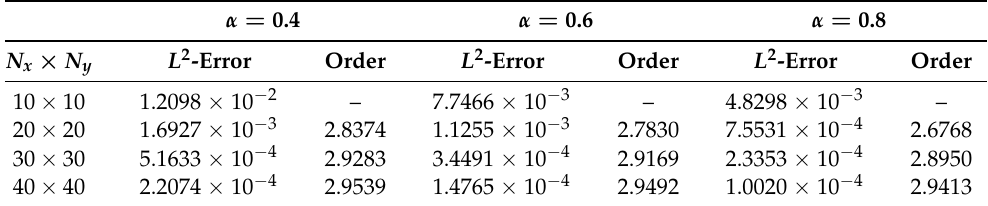
Table 8. The L 2 -norm errors and spatial convergence orders for Example 2 using scheme (48), M = 3000, T = 1/4, r = ( 3 − α ) / α , k =